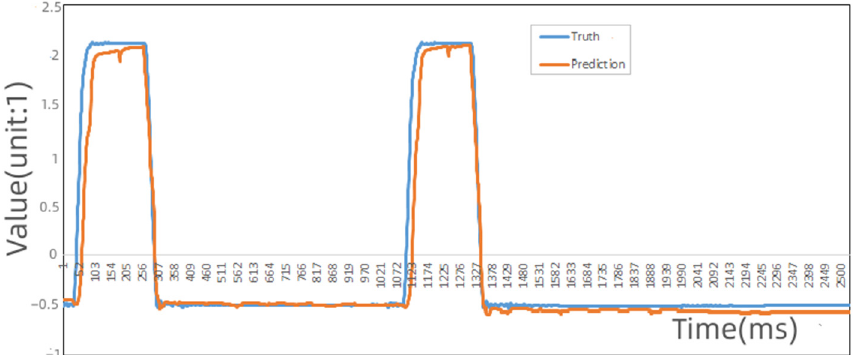
Figure 5. The predicted and actual values of information source D1 using the Informer algorithm.